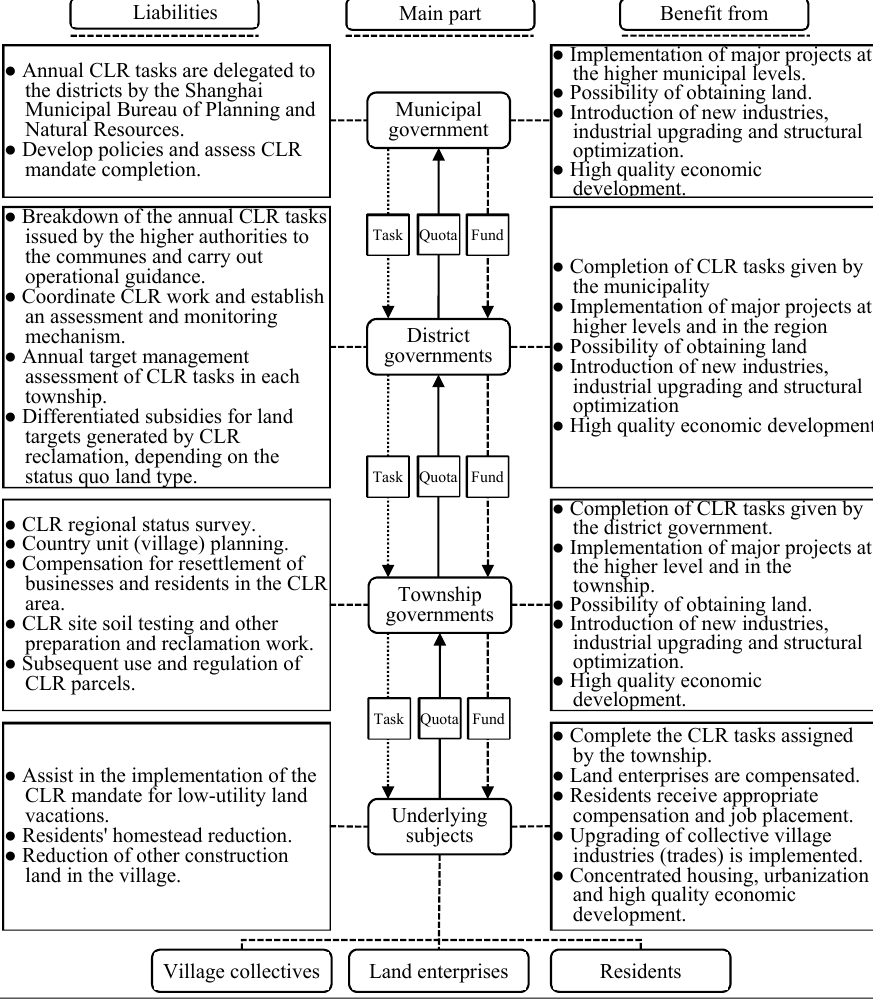
Figure 1. Task, quota, financial and benefit flows in the CLR process.